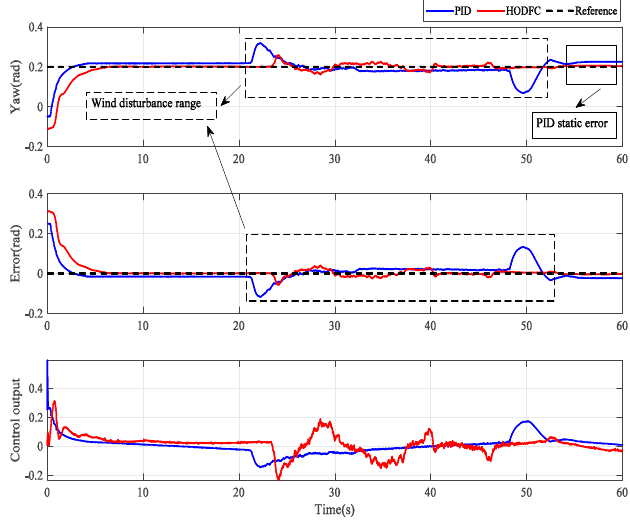
Figure 18. Experimental results of yaw with wind disturbance. Table 5. Numerical performance metrics of static trajectory with disturbance.